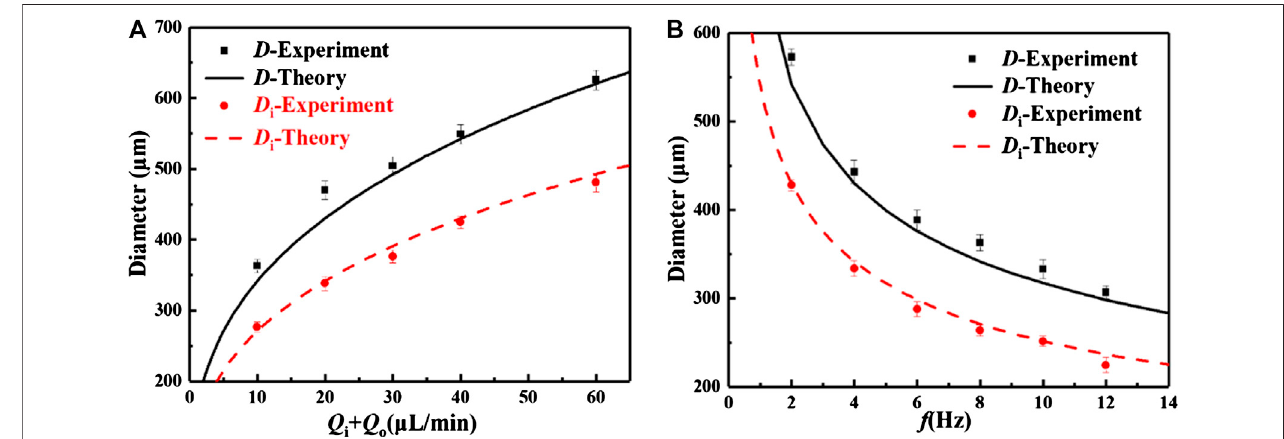
FIGURE3| In fl uenceofexperimentalparametersonthesizeofthedoubleemulsion. (A) Therelationshipsbetweentotal fl owrateandcoreandshellsizes( f (cid:1) 8 Hz, Q i (cid:1) Q o ). (B) The relationships between vibration frequency and core and shell sizes ( Q i + Q o (cid:1) 10 μ L/min, Q i (cid:1) Q o ).